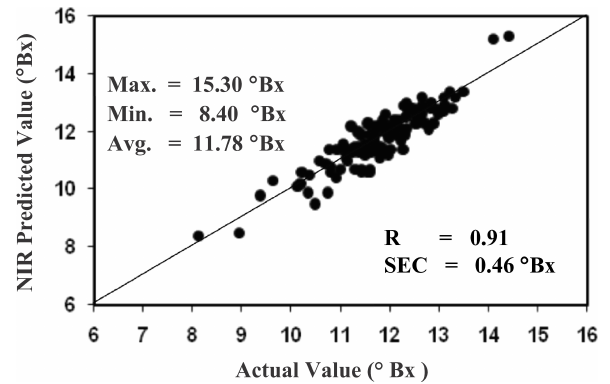
Fig. 6. Second derivative spectrum of